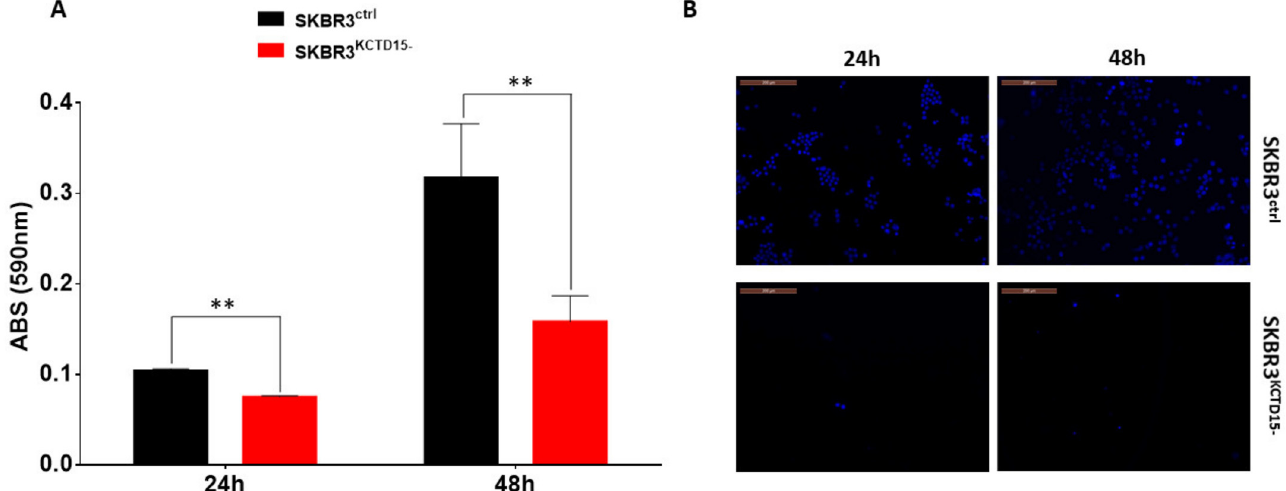
Figure 6. KCTD15 silencing influences the SKBR3 migration. SKBR3ctrl and SKBR3 KCTD15 − mi- gration was determined using trans-well chamber by Crystal violet ( A ) and DAPI ( B ) staining of migrated cells. ** = p < 0.01 Mann–Whitney T-test. Crystal violet signal (590 nm) is reported as mean +/ − SD of three technical independent experiments. For DAPI staining, the magnification reported is 20 × . Scale bars 200 µ